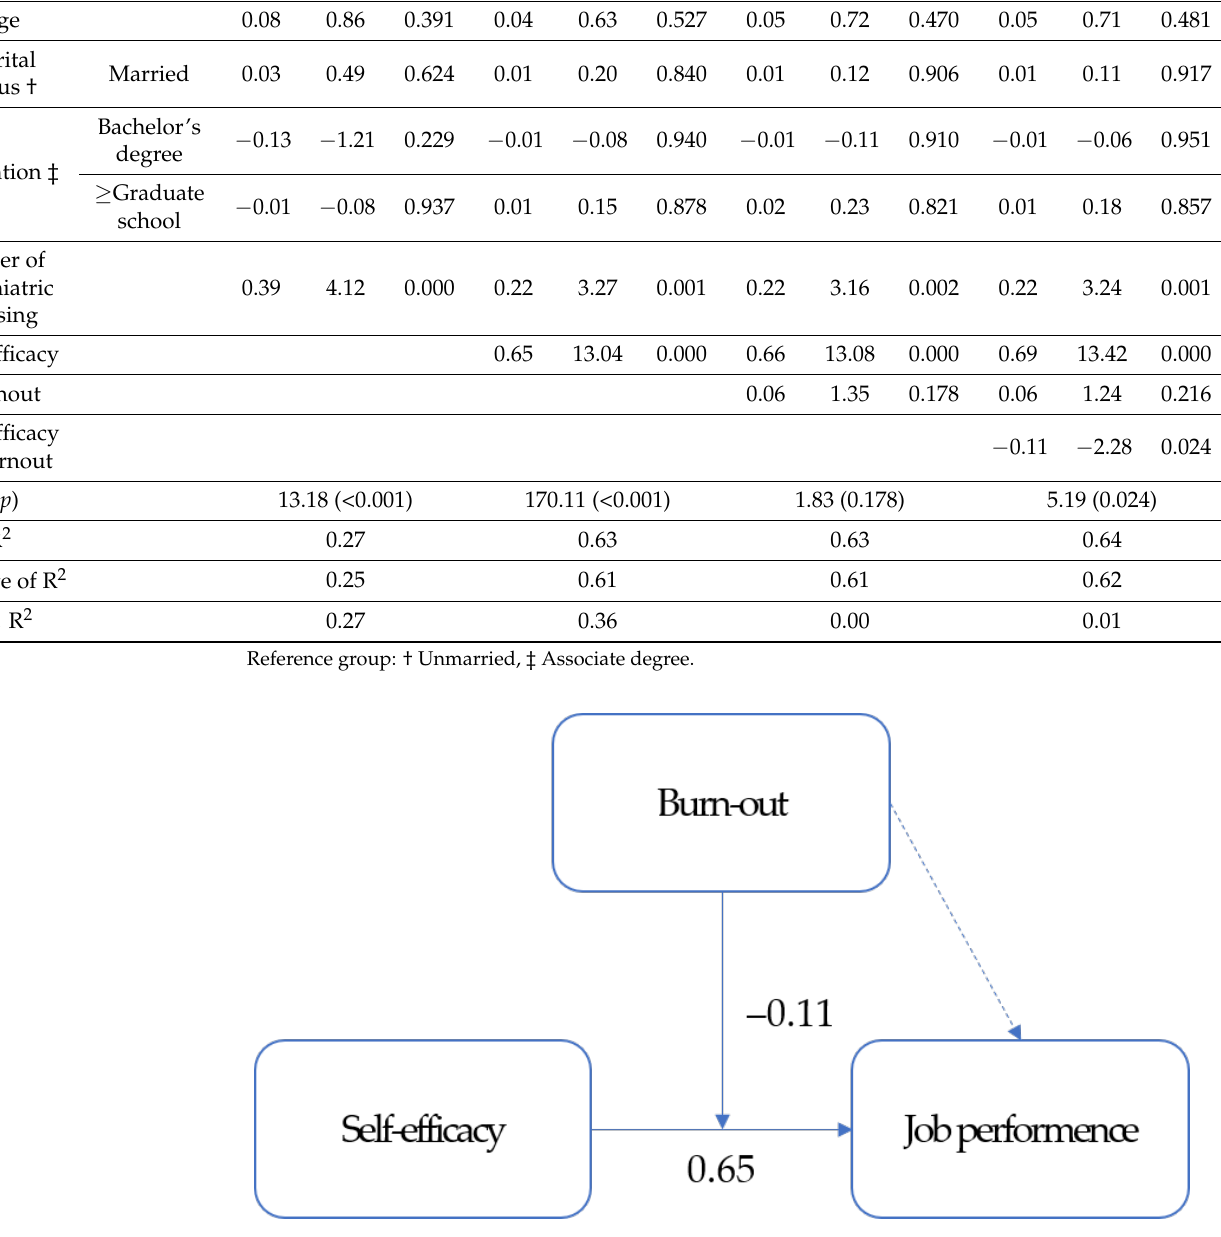
Figure 1. Moderating effect of burnout on the relationship between self-efficacy and job perfor- mance